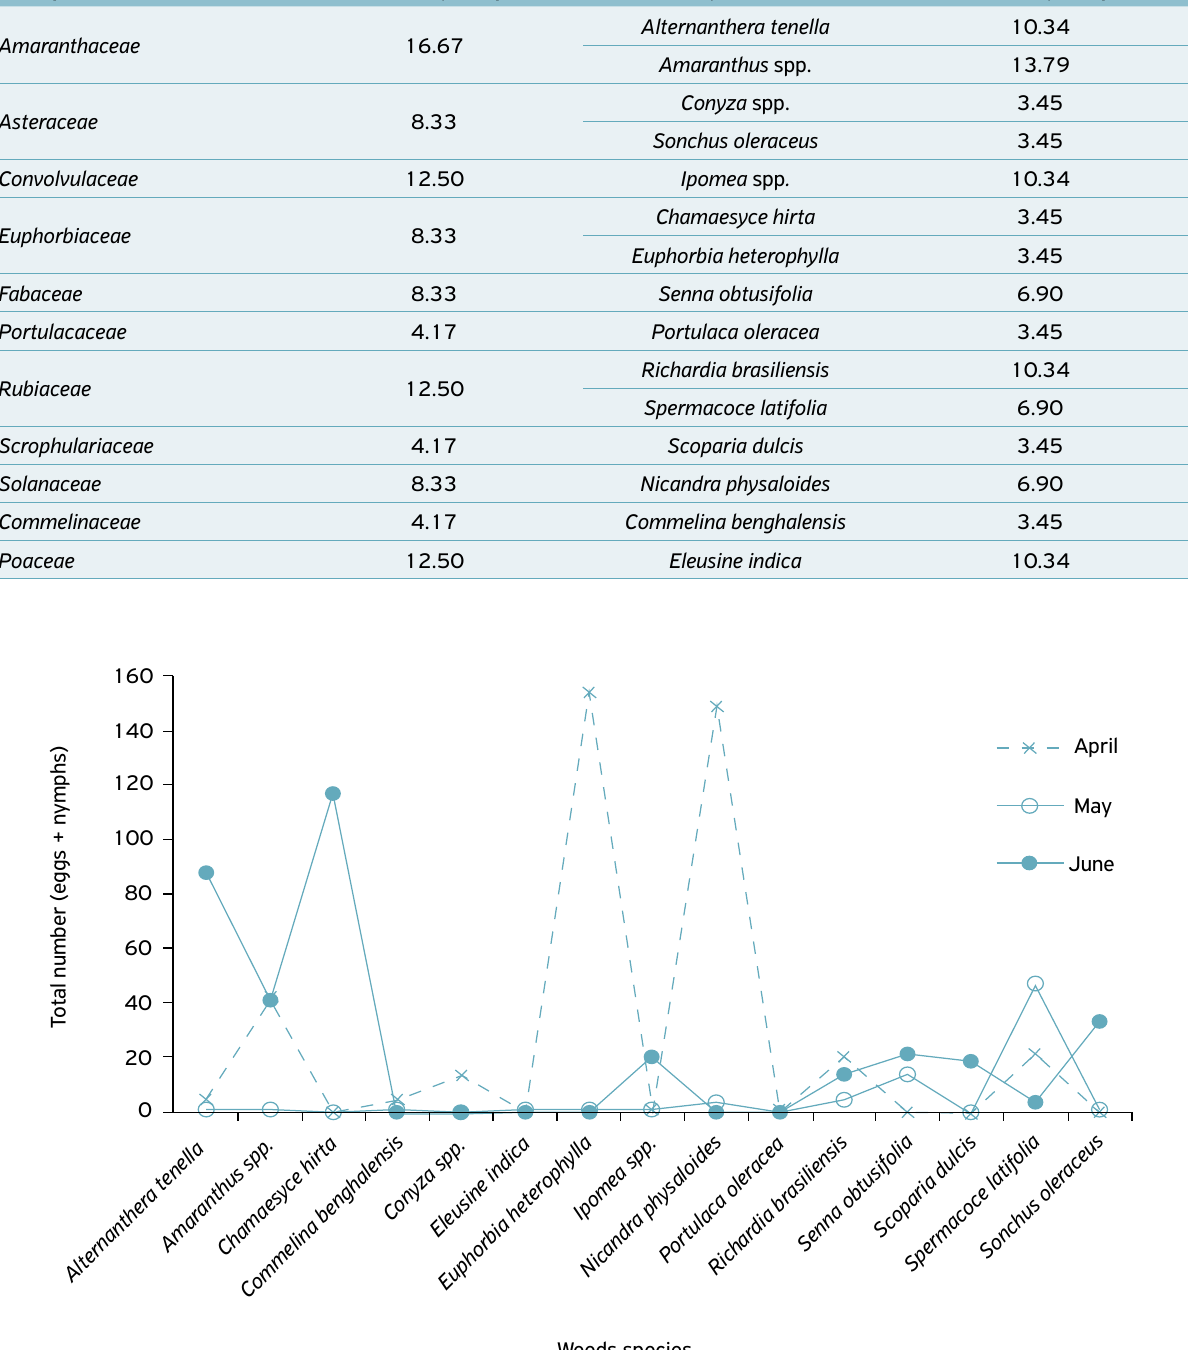
Table 1. Weed community in the FM 975 WS cultivar cotton crop from April to June 2015, Sinop, Mato Grosso, Brazil. Family Relative frequency (%) Species